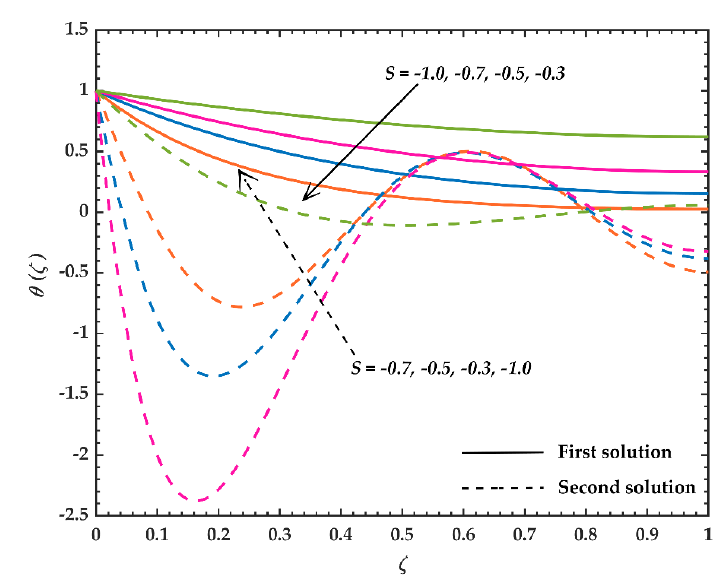
Figure 7. Temperature profiles, θ ( ζ ) when Pr = 30, We = 0.2, n = 0.6, M = 2 and σ = 1.2 as S varies.